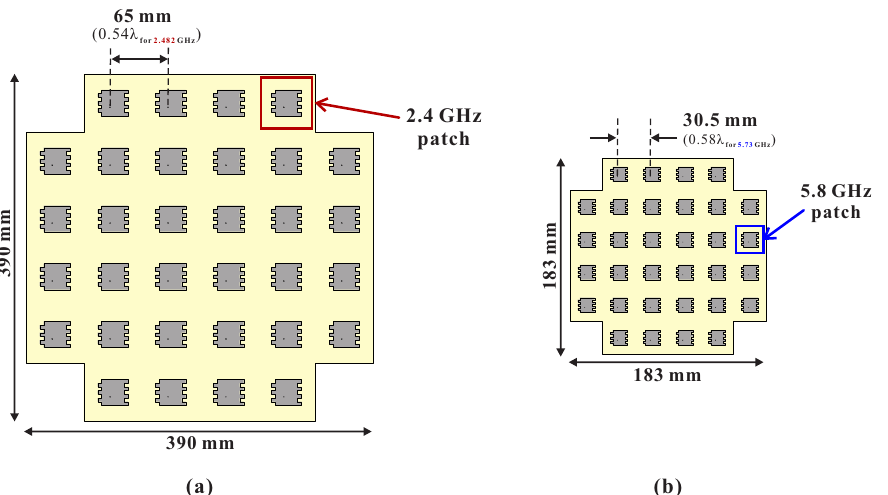
Figure 8. Single-band array antennas with performance equivalent to the proposed shared-aperture array: ( a ) 2.4 GHz array; ( b ) 5.8 GHz array.